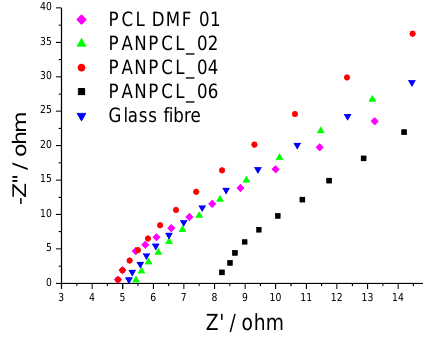
Figure 6. Electrochemical Impedance Spectroscopy of a symmetric Li/separator/Li cell. The graph on the right is an enlargement of the high frequency domain.